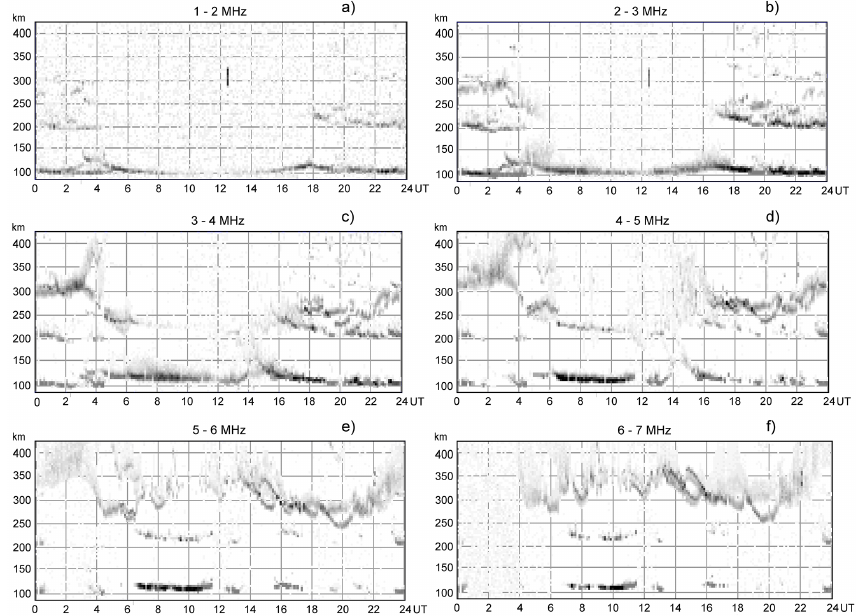
Figure 2. HTI plots averaged over two consecutive days, the 11 and 12 June 2013. Each plot corresponds to a different frequency range: (a) 1–2MHz, (b) 2–3MHz, (c) 3–4MHz, (d) 4–5MHz, (e) 5–6MHz, and (f)